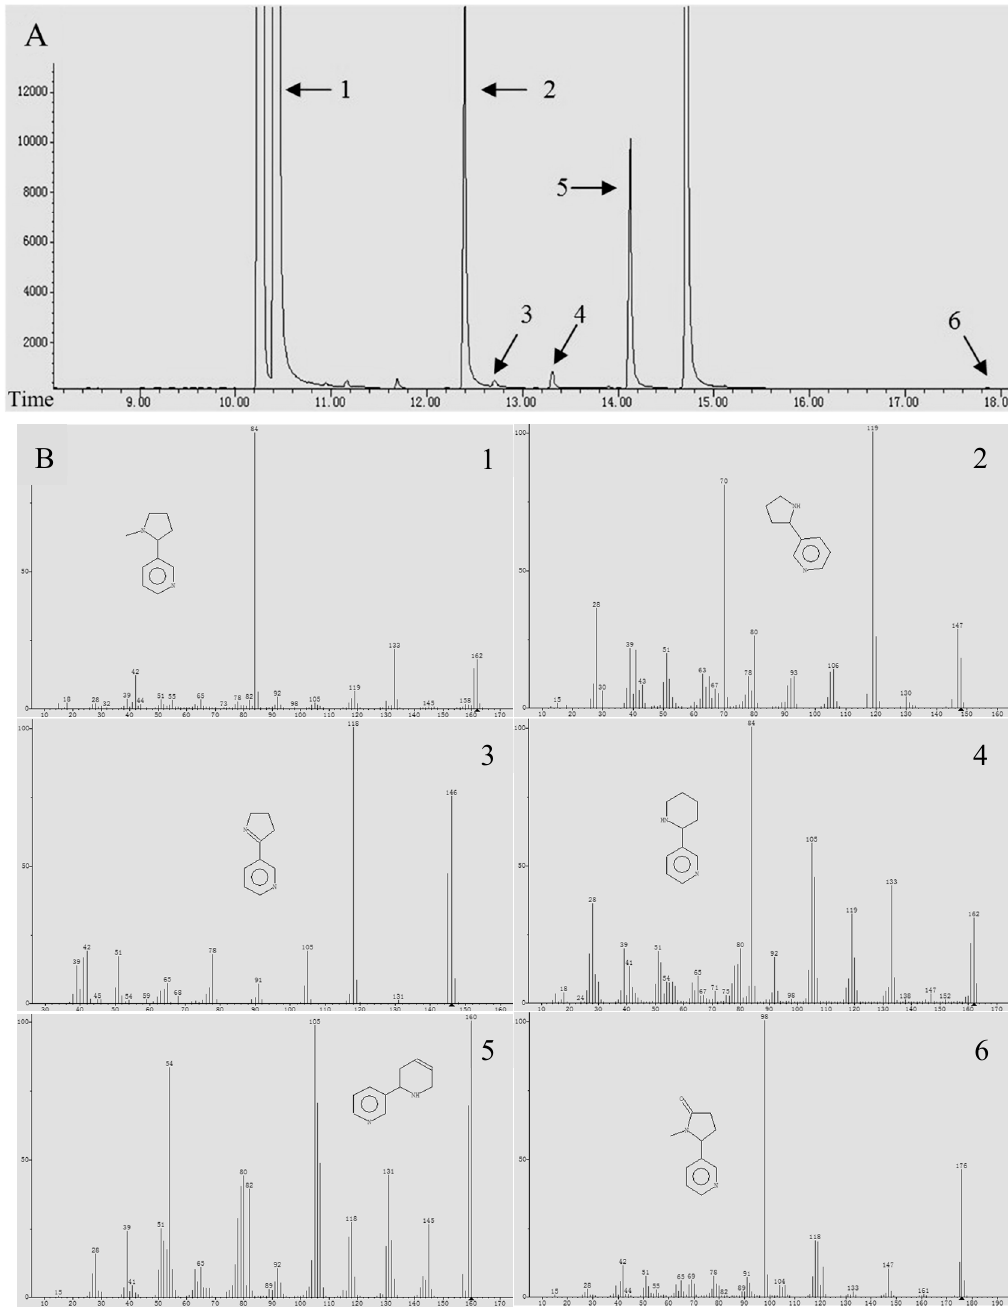
Figure 2. Gas chromatography-selected ion monitoring mode-mass spectrometry (GC–SIM-MS) chromatogram of alkaloids in Nicotiana tabacum . ( A ) Total ion current (TIC) chromatogram of alkaloids in Nicotiana tabacum . Peaks: (1) nicotine; (2) nornicotine; (3) myosmine; (4) anabasine; (5) anatabine; (6) cotinine. ( B ) The mass spectra of corresponding alkaloids in the chromatogram.